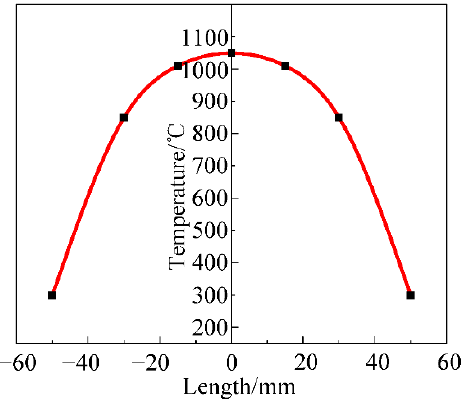
Figure 8. Cr5 alloy steel tensile specimen temperature distribution.